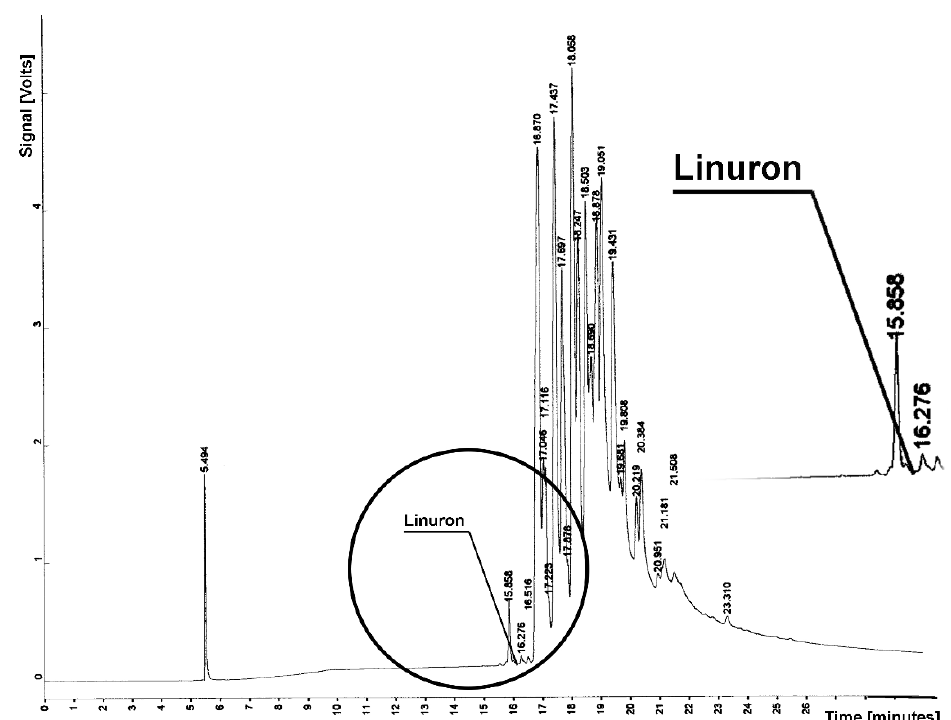
Figure 1. Chromatogram from determination of atrazine residue in sample from soil extraction; tR = 16.576—atrazine .